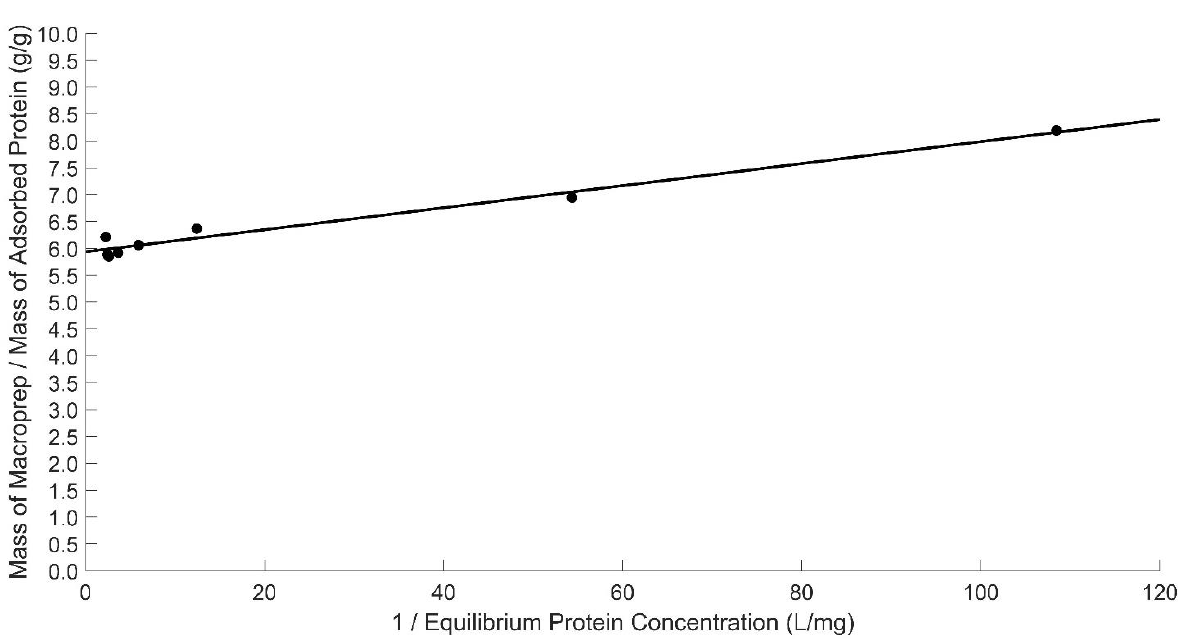
Figure 1. Protein adsorption by Macro-Prep ® in model wine solutions with different pH values. Protein concentration was measured by using the Bradford protein assay and a UV-Vis spectrome- ter at 595 nm.